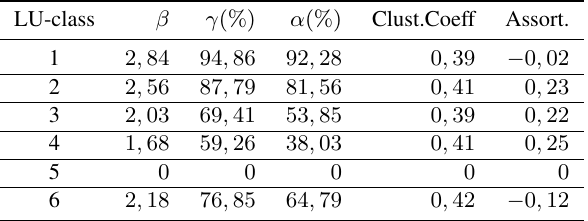
Table 2: Graph measures of planar building graphs